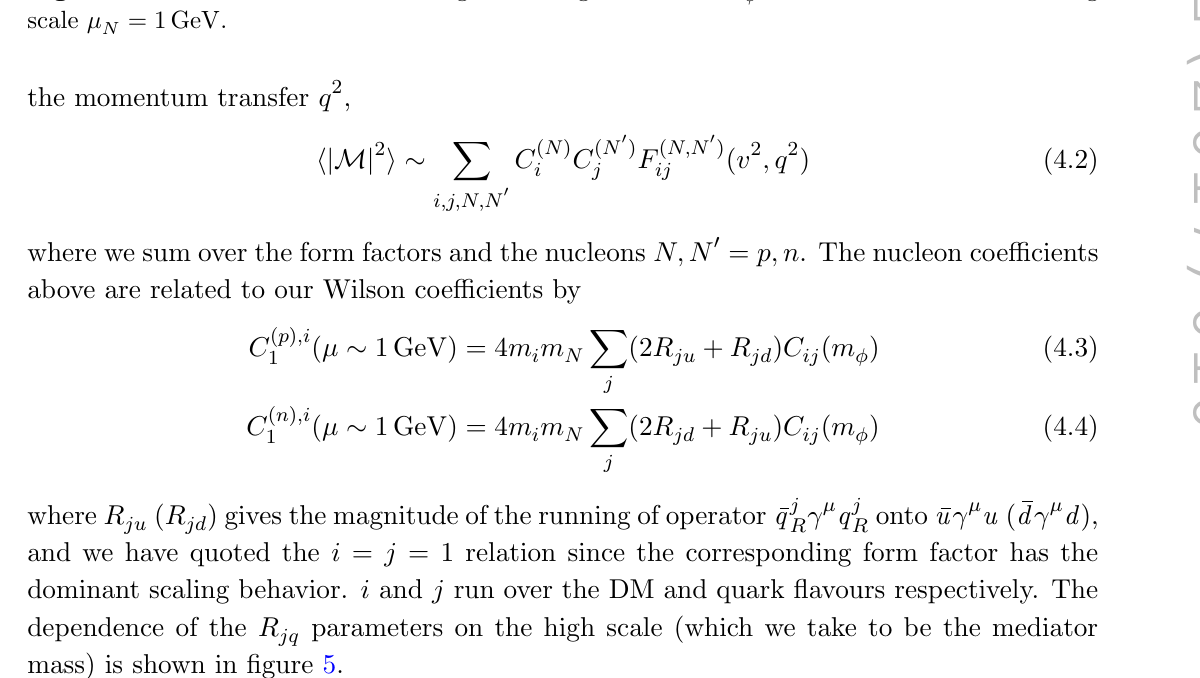
down to the nuclear scattering (cid:30)